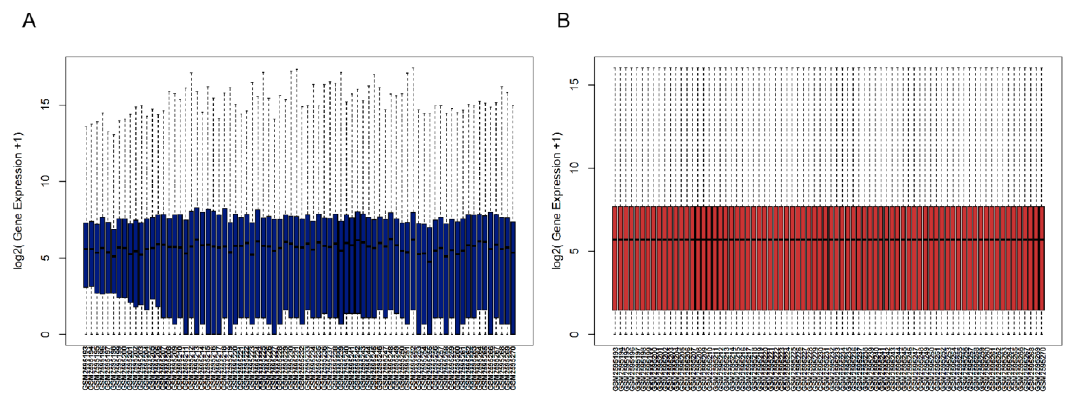
Figure 1. Box plots of gene expression data of GSE98394 datasets ( A ) before and ( B ) after normalization. The x-axis represents the gene expression level and the y-axis represents the samples.